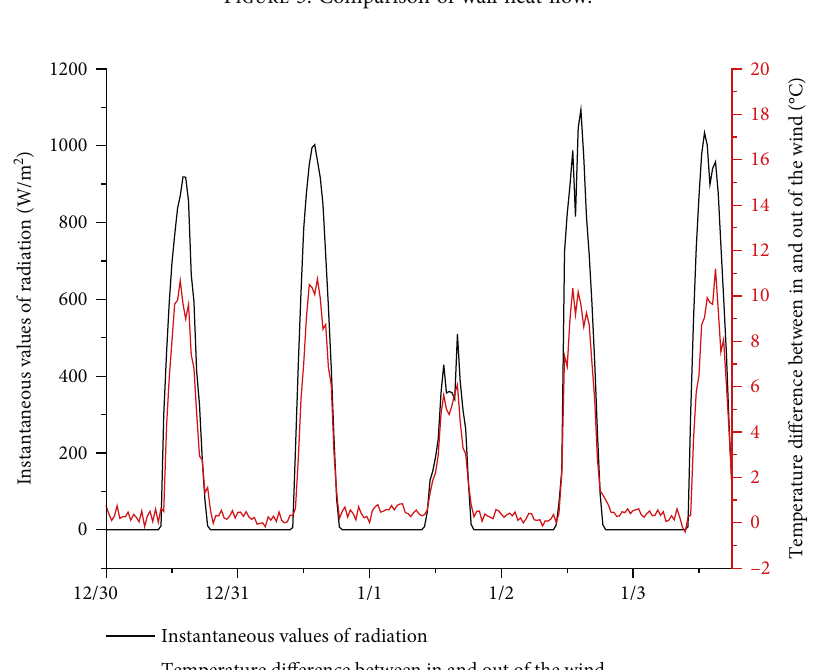
Figure 5: Comparison of wall heat fl ow.